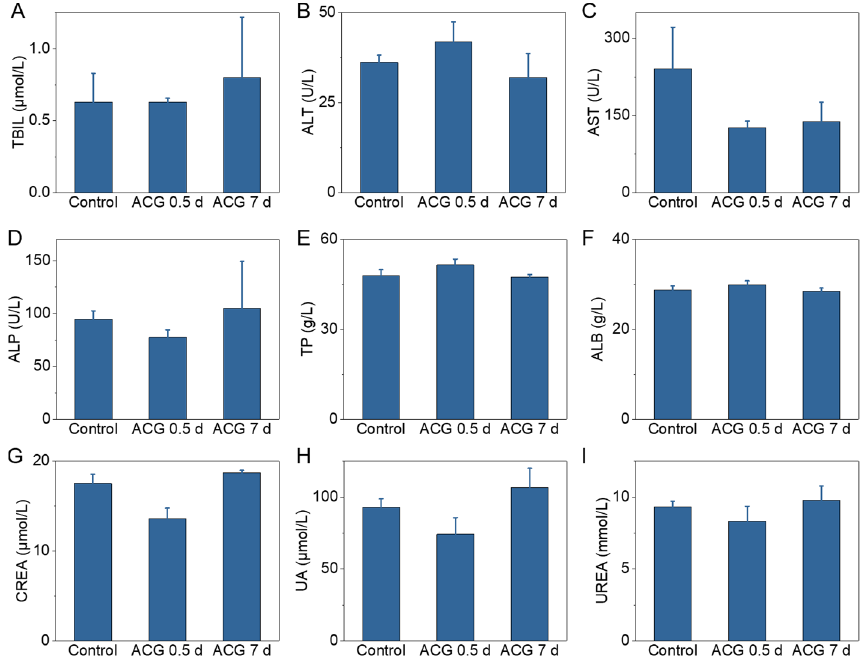
Figure 7. The biochemical analysis of mice with different treatments. ( A ) TBIL. ( B ) ALT. ( C ) AST. ( D ) ALP. ( E ) TP. ( F ) ALB. ( G ) CREA. ( H ) UA. ( I ) UERA. Data shown as means ± SD, n = 3. Control: blood sample collection of tumor-bearing mice without other interference. ACG 0.5 d: blood sample collection at 0.5 d after intratumoral injection of 50 μ L ACG hydrogel. ACG 7 d: blood sample collection at 7 d after intratumoral injection of 50 μ L ACG hydrogel.